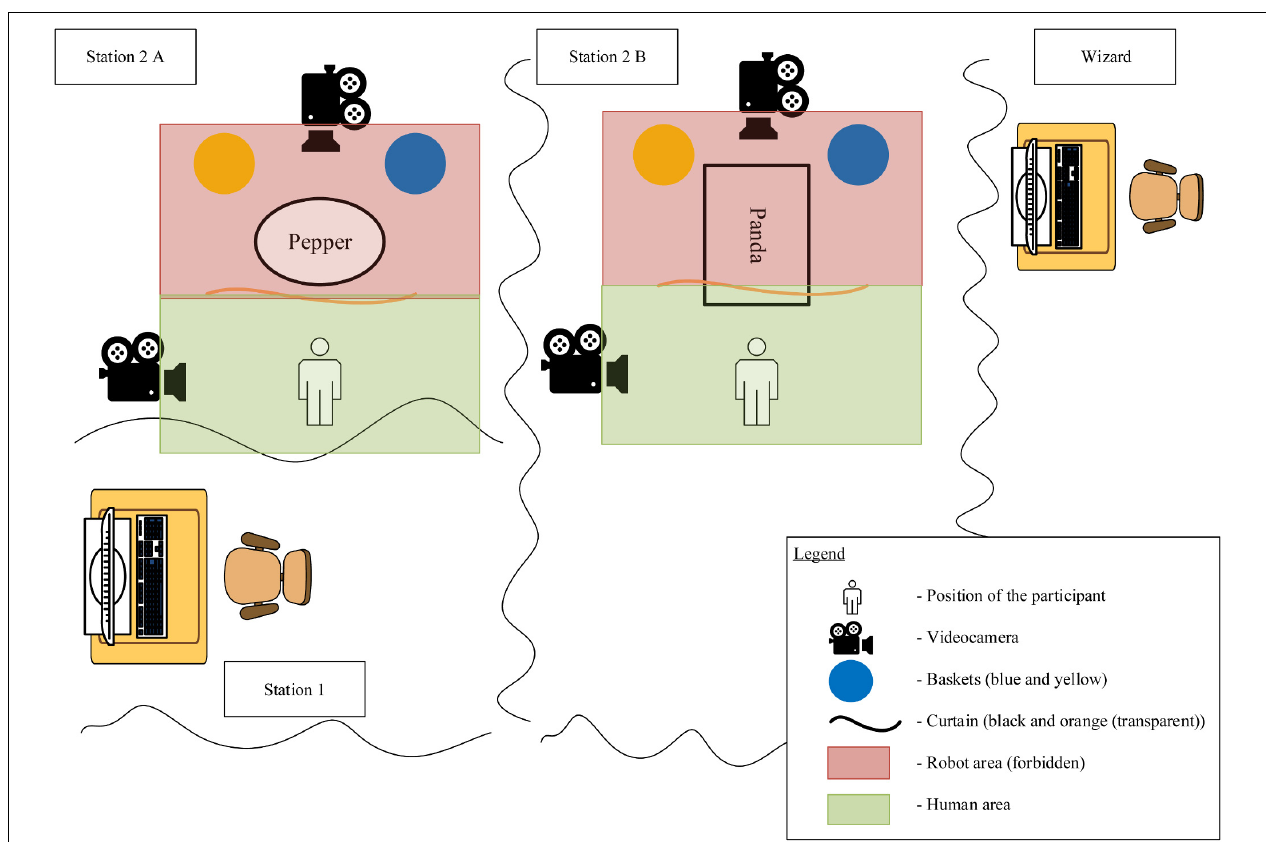
FIGURE 2 | Setup of the human–robot interaction experiment from